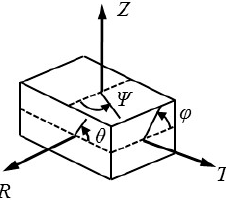
Figure 18. Definition of local cylindrical coordinate system RTZ . Notably, θ and φ coincide with the branch angles defined earlier in Figure 5.